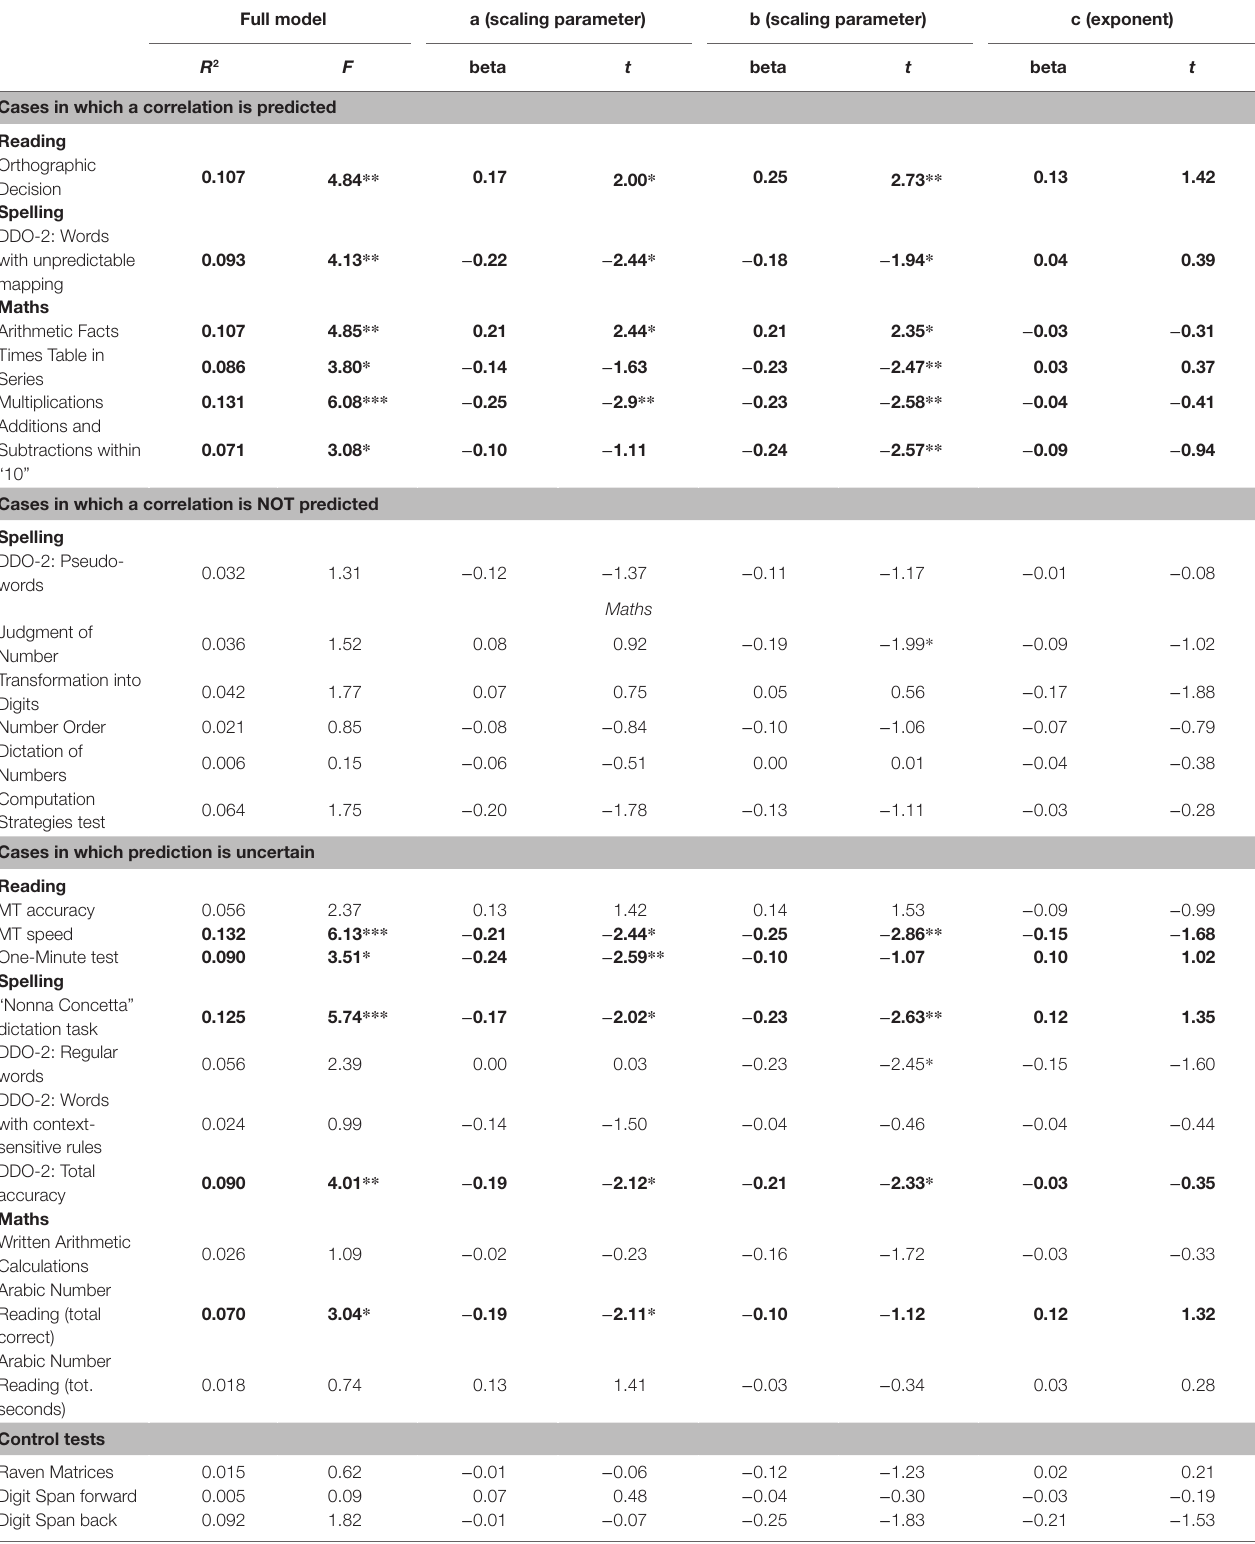
TABLE 1 | Each line of the table reports the results of a separate multiple regression analysis. Full